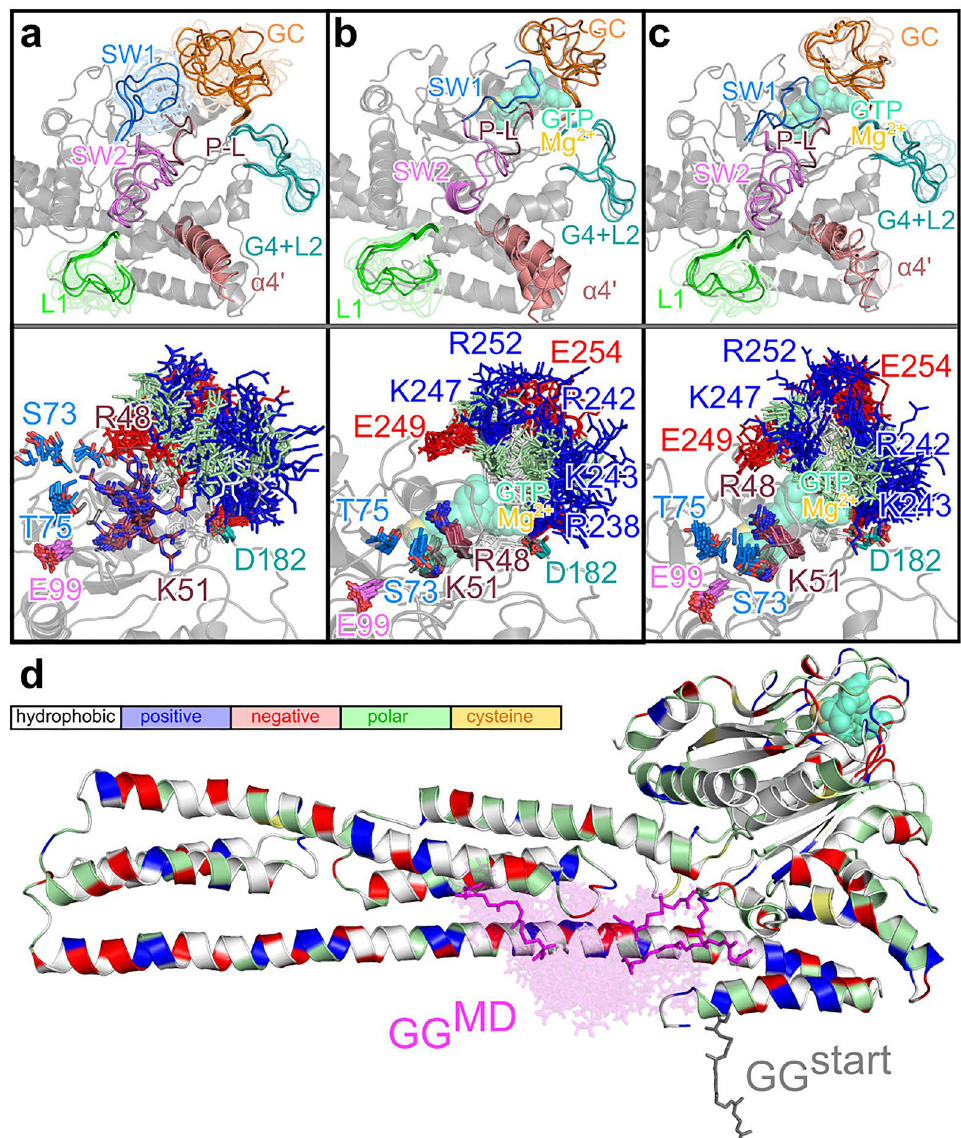
Figure 3. Conformational clusters of the G domain loops of ( a ) mGBP2 apo , ( b ) mGBP2 GTP , and ( c ) mGBP2 holo as well as ( d ) for the geranylgeranyl anchor. ( a – c ) In the upper panels, the central conformations for the five most populated clusters (or fewer if < 5 were found) are shown in opaque and for the other clusters in transparent, using different colors for the different loops as specified in the figures. For mGBP2 GTP and mGBP2 holo , the GTP-binding pocket is indicated by showing GTP and Mg 2 + (in transparent green and light orange). The helix α 4 ’ is also highlighted in light red. The homology model of mGBP2 is shown as reference in a gray cartoon representation. In the lower panels, the different conformations of key residues for all clusters are shown, as sticks colored according to their residue type (white: apolar; green: polar; blue: positively charged; red: negatively charged), and labeled. ( d ) The central cluster conformations of the geranylgeranyl group (GG, magenta sticks) of mGBP2 holo are shown in opaque for the three most populated clusters and in transparent for all other clusters. The initial conformation of the geranylgeranyl group used to start the HREMD simulation is also depicted (gray sticks), while the homology model of the whole protein is presented as cartoon and colored based on residue type as explained in the legend